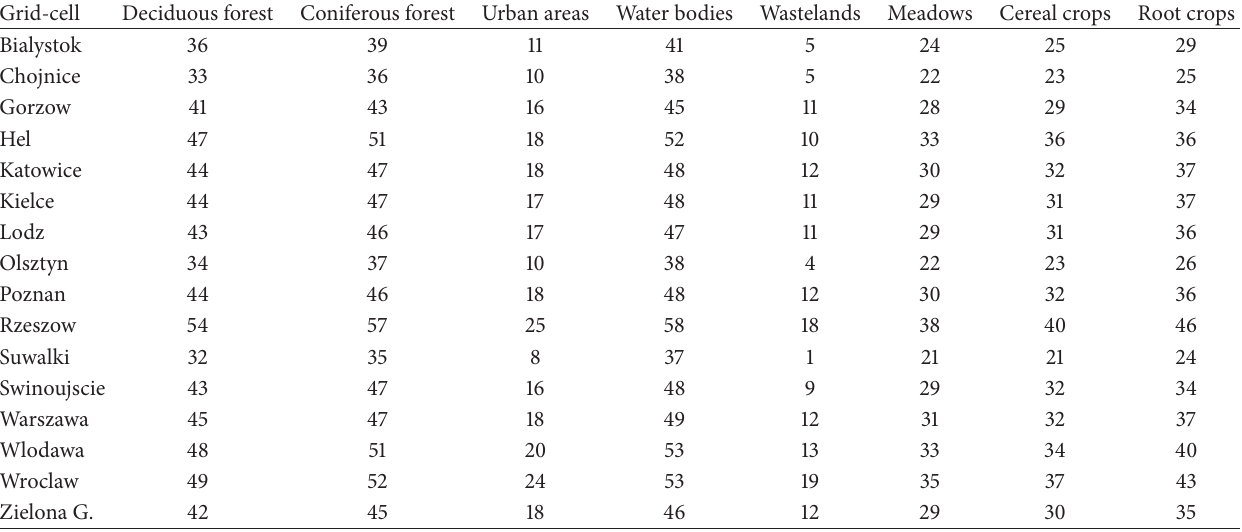
Table 9: The increases of the annual evaporation [in mm] from different land-use units in the future (2061–2090) compared to the control period 1961–1990, based on five models (average values).